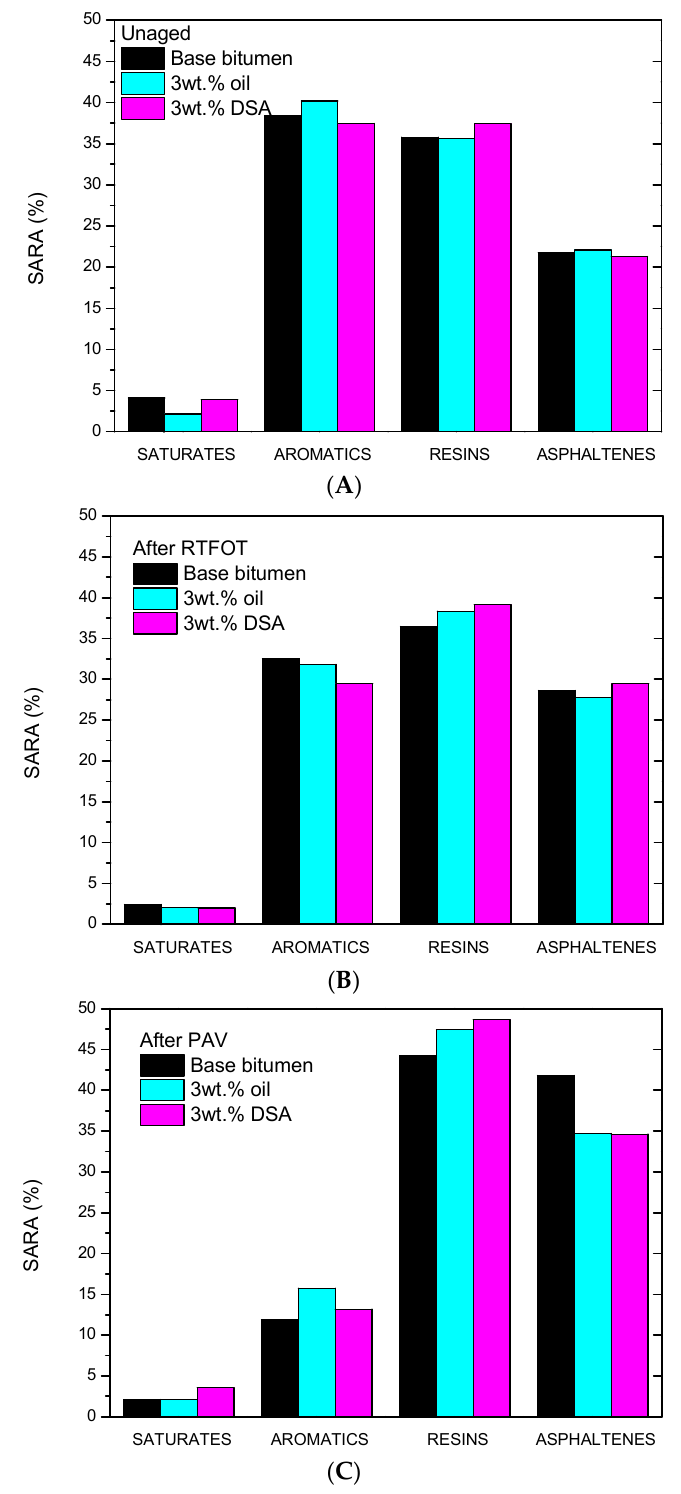
Figure 9. SARA composition for neat and modified bitumen ( A ) before ageing, ( B ) after RTFOT and ( C ) after RTOFT + PAV.